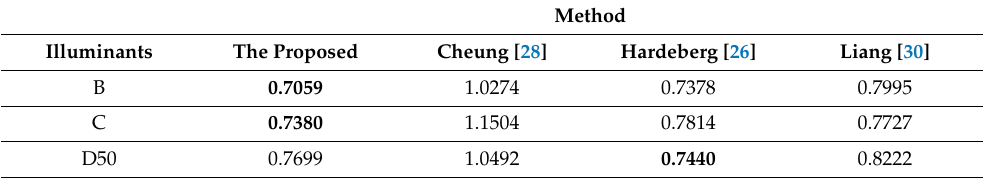
Table 5. The spectral recovery color difference of selected representative samples to recover total